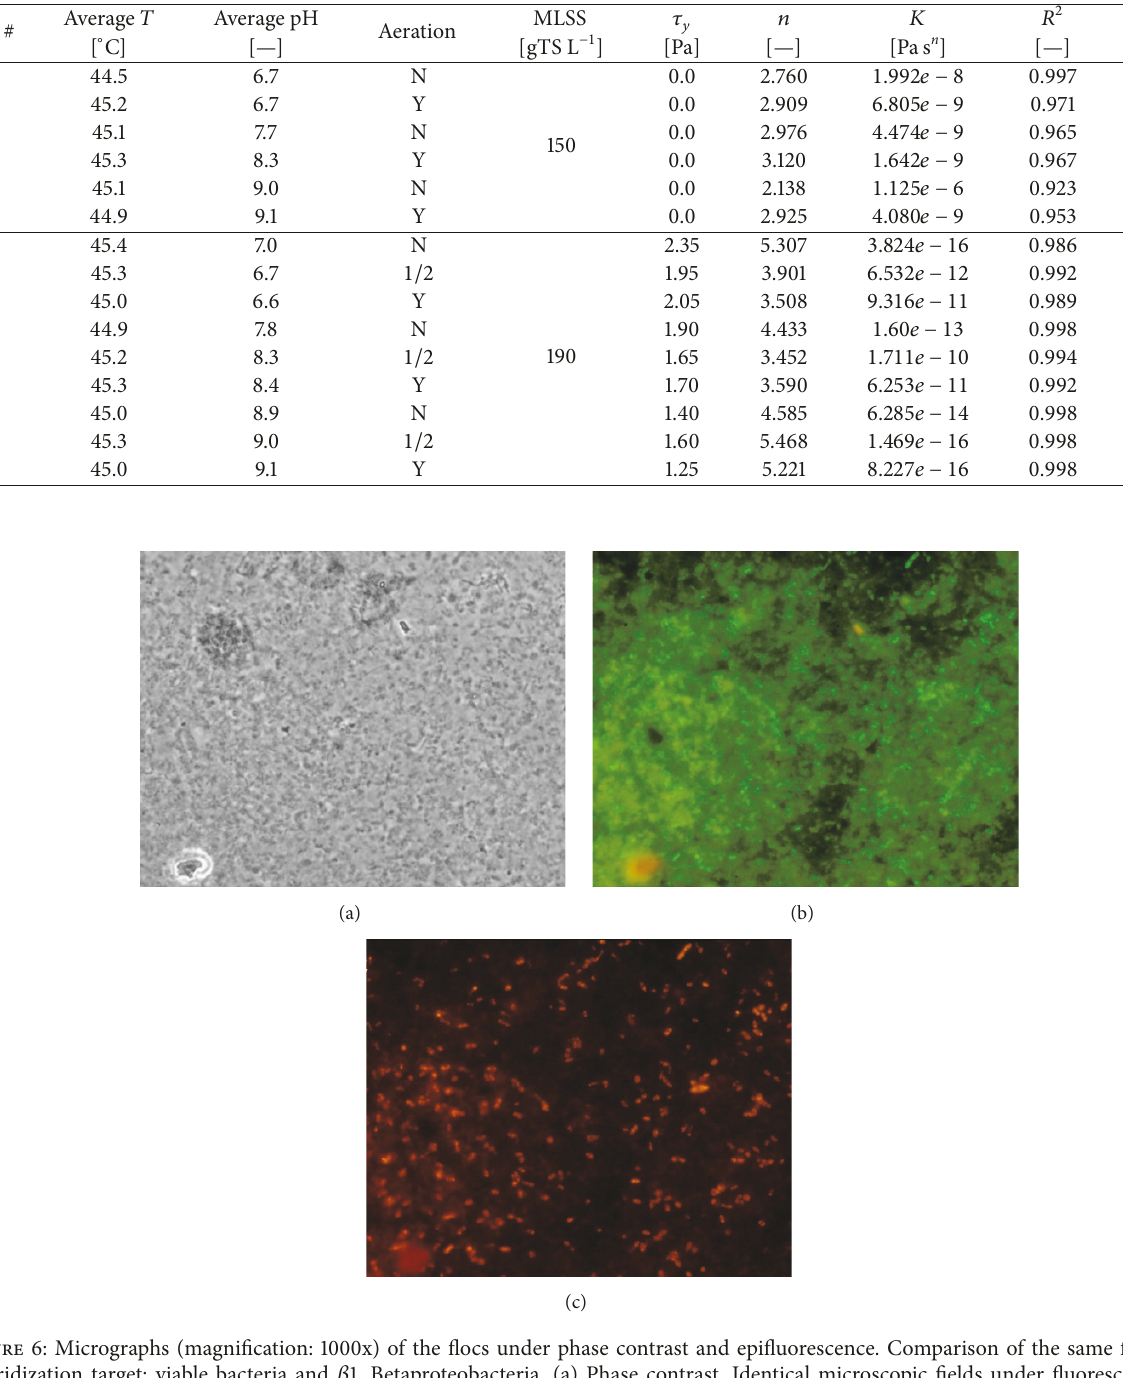
Table 3: Summary of rheological tests and results of linear regression analysis.